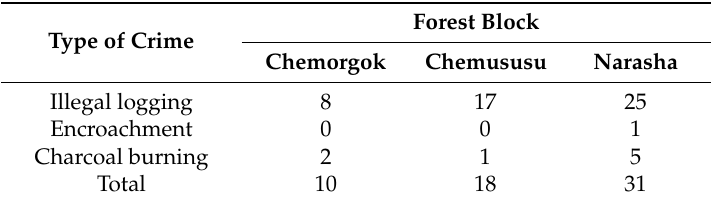
Table 10. Crime reported between December 2012 and June